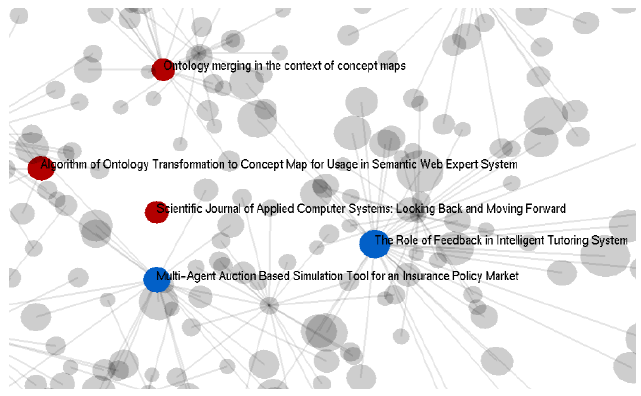
Fig. 11. Application of